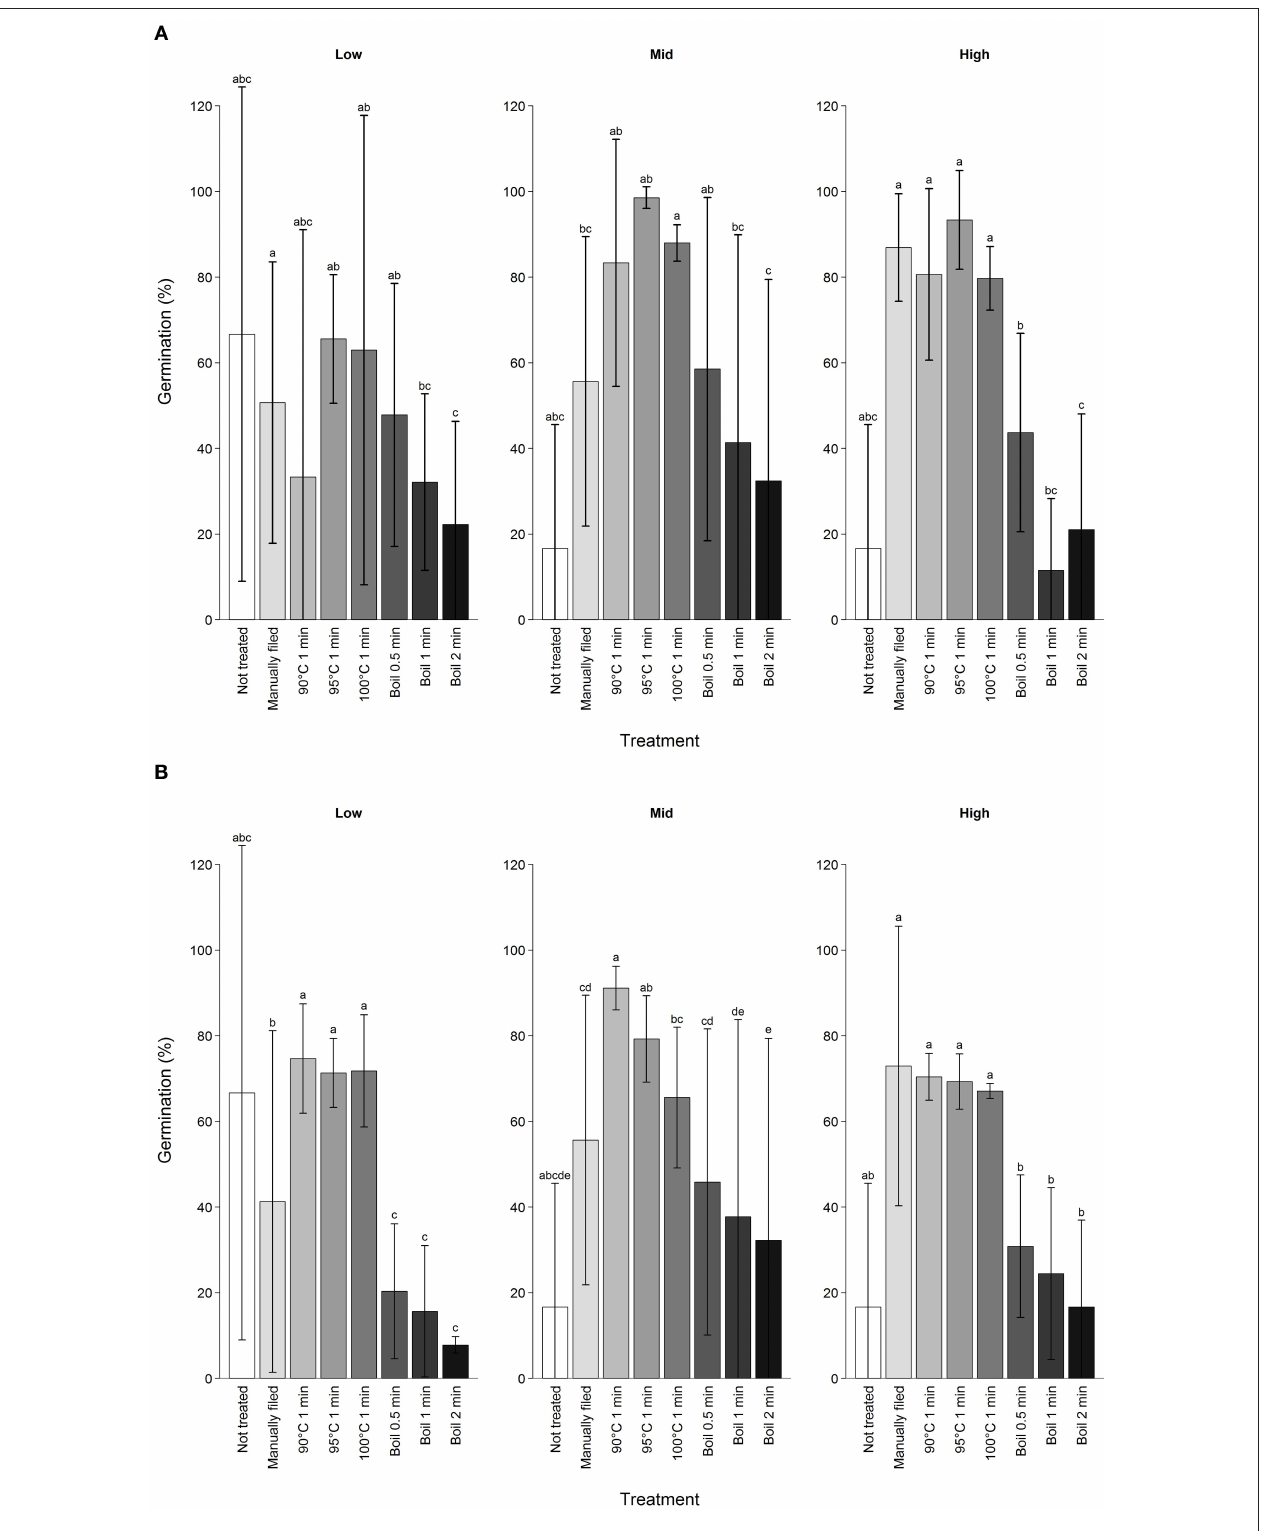
FIGURE 3 | Germination percentage of koa seeds by different scarification treatment after (A) first treatment attempt and (B) first through up to 15 attempts combined excluding those that were subjected to manual filing afterwards. Scarification treatments are ordered from the least intense to the most intense from left to right, indicated by the darkness of the bar color. Error bars are standard deviation for seeds from three trees per elevation range. Different letters indicate difference in total germination percentage among treatments for each elevation range at α = 0.05.